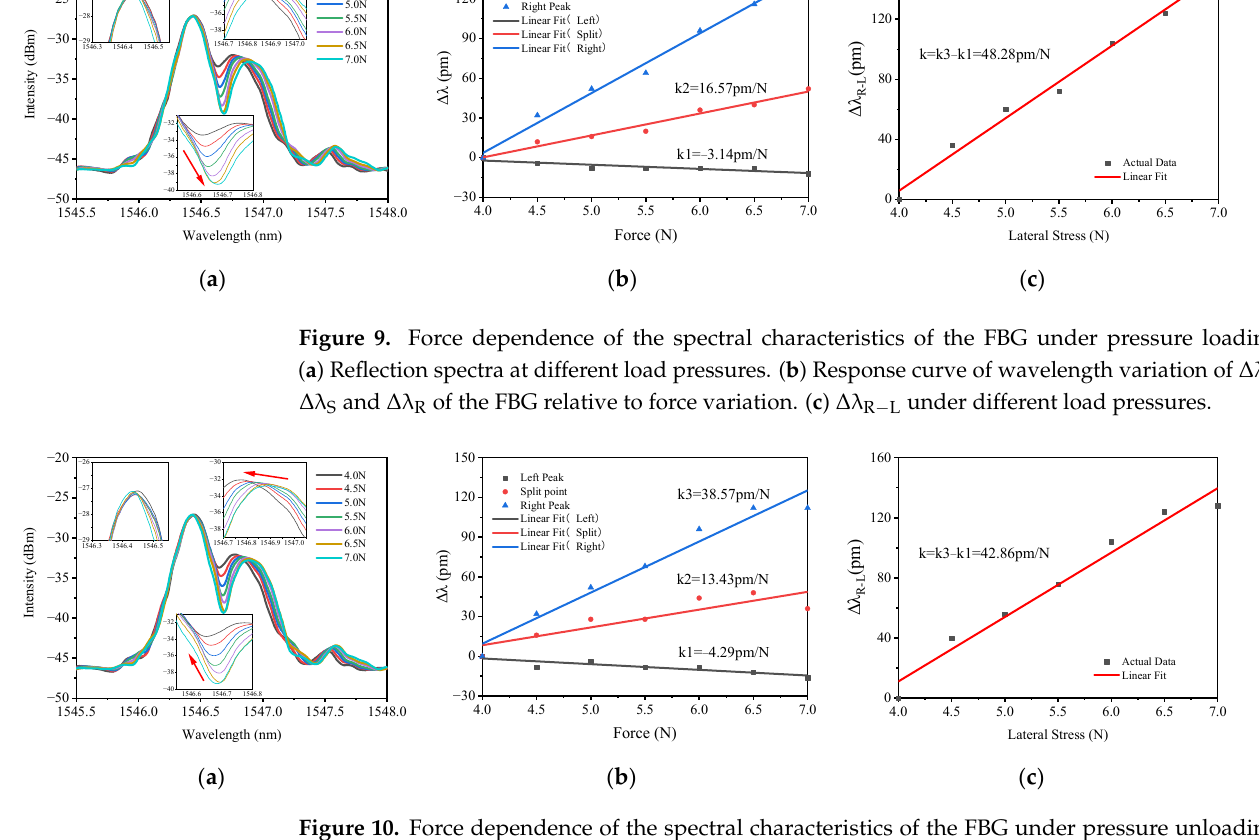
Figure 8. Reflection spectra under different stress ( a ) 0 N ( b ) 1.5 N ( c ) 3.0 N ( d ) 4.0 N. The experiment included lateral stress loading and unloading in a range from 4.0 N to 7.0 N, with a step of 0.5 N. The spectra are shown in Figures 9 and 10, and the data are listed in Table 1. Let the left peak wavelength shift be ∆ λ L , the split point wavelength shift be ∆ λ S , and the right peak wavelength shift be ∆ λ R ; the wavelength difference between the left and right peaks is ∆ λ R − L = λ R − λ L . Table 1. Experimental results of local lateral forces and left peak, split point, and right peak wave- lengths for the FBG.